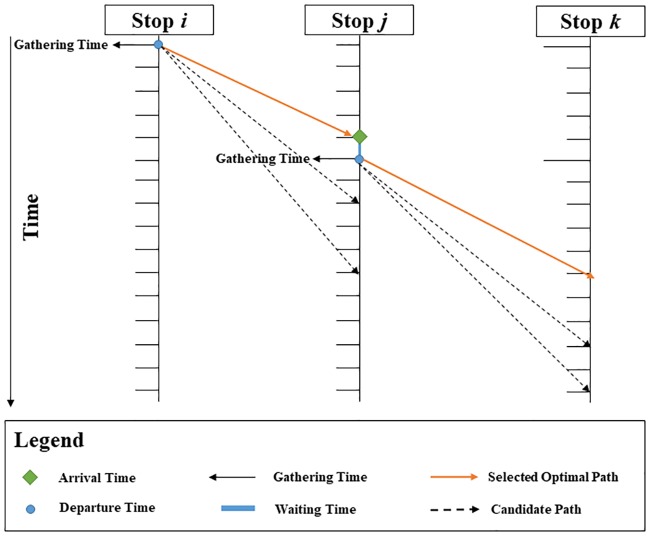
An illustration of SBRP in STD networks.